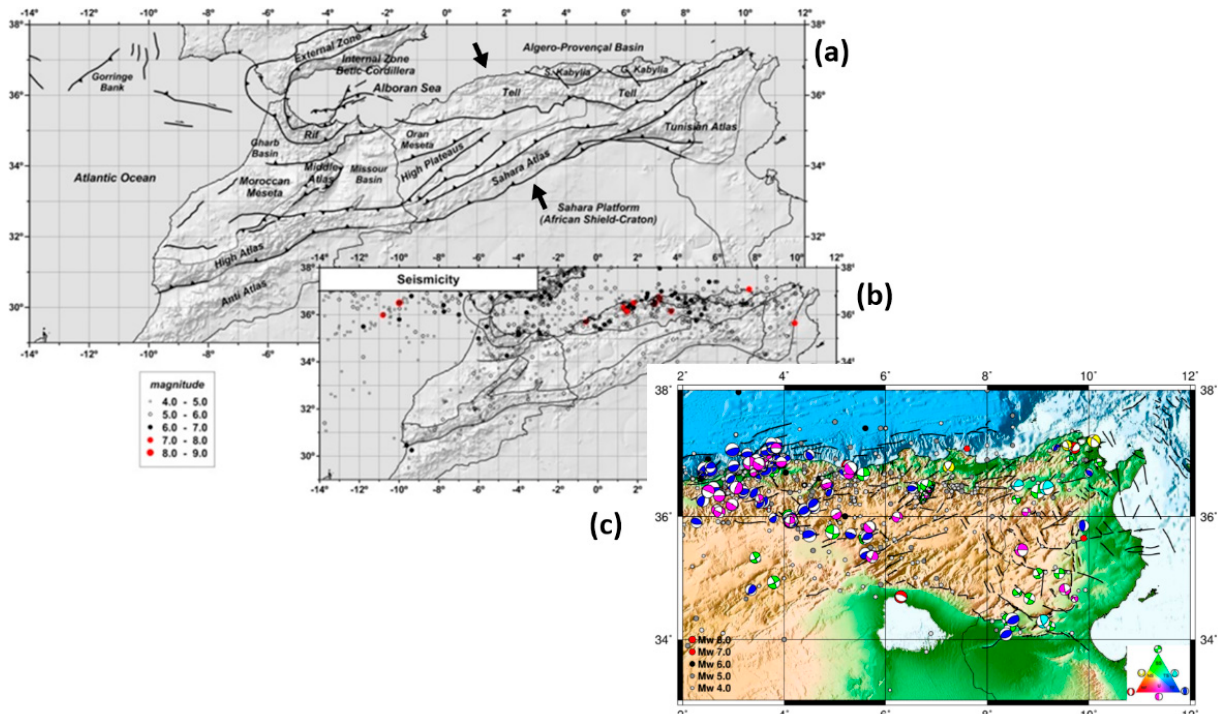
Figure 1. Tectonic and seismicity frame. ( a ) Tectonic sketch for the studied region. ( b ) Sha-low seismicity with depth less than 30 km and magnitude above magnitude Mw 4.0. ( c ) Distribution of seismicity with magnitude above Mw 4.0 and distribution of focal mechanism solutions.